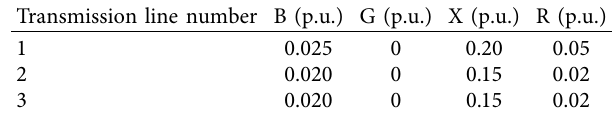
Table 1: Transmission line parameters for the 3-bus